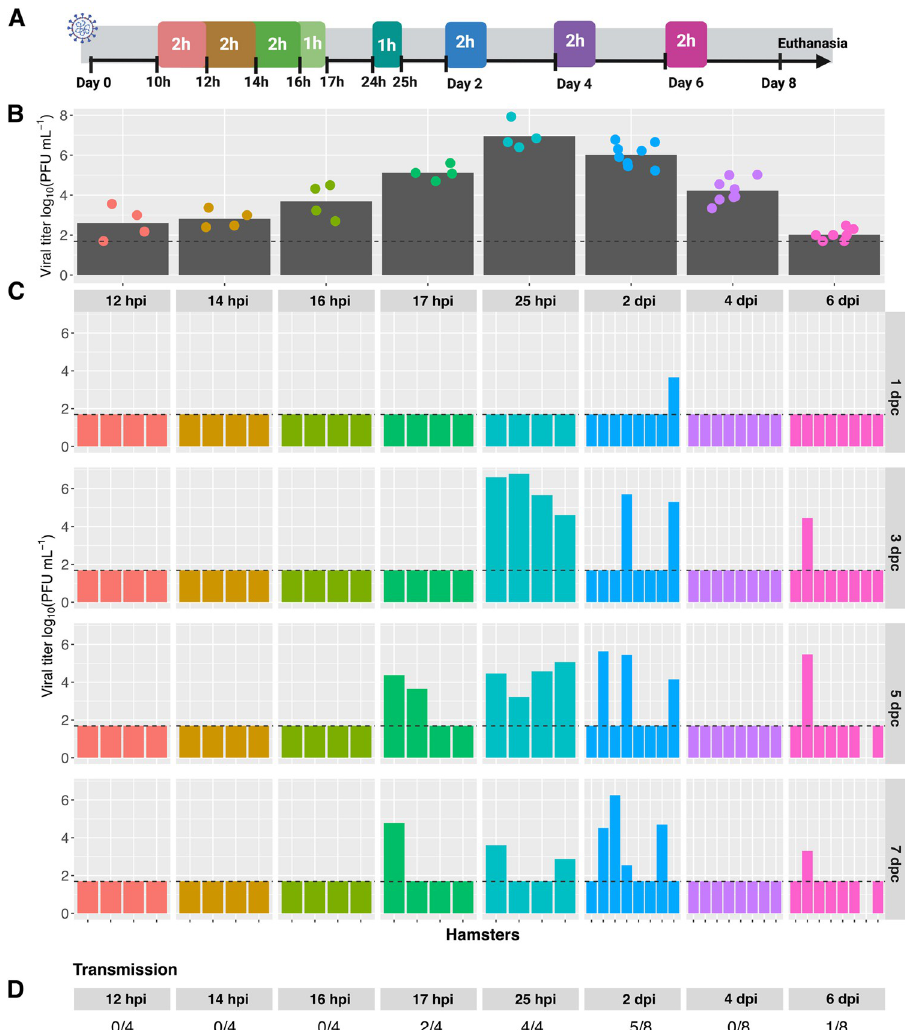
Fig 2. Period of transmissibility corresponds to period of high viral load in donor animals. A] Schematic depicting experimental timeline. Animals were inoculated with 1x10 2 PFU [titered on VeroE6 cells] at Day 0 and exposures initiated at Day 1. Colored boxes show the different exposure times, with the duration indicated within each box and the start times indicated with black ticks. B] Viral load in inoculated animals at the conclusion of the exposure period. Time points are indicated under the x-axis and a different color is assigned to each different exposure time. Bars show mean viral titer and dots show individual hamsters. C] Viral titers in nasal washes collected from contacts. Different exposure periods are shown with different colors. The time post-inoculation at which the exposure period concluded is shown at the top of each facet. Time points at which nasal wash samples were collected are shown at the right of each row in units of days post contact [dpc]. For the early exposure groups, n = 4 transmission pairs. For the 2 dpi, 4 dpi and 6 dpi exposure groups, data from two independent experiments are displayed together giving total n = 8 transmission pairs. All exposures were carried out at 20˚C and 50% RH. Horizontal dashed line indicates limit of detection [50 PFU]. Missing data indicate that the animal died or was euthanized mid-way through the experiment. D] The fraction of transmission pairs in which recipients shed infectious virus at one or more time points is indicated. Group comparison using Fisher’s exact test revealed that differences in transmission were statistically significant [P =